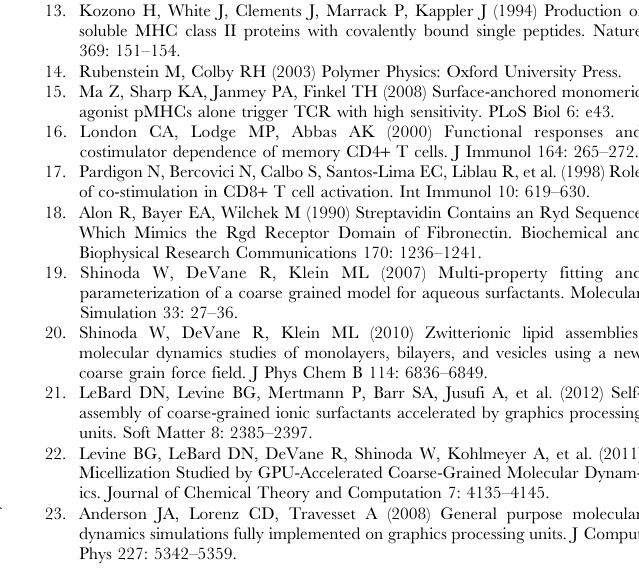
time and 0 second intervals. Figure S3 Similar densities of IEk-MCC tethered on plastic through PEG linkers of different lengths. IEkMCC-PEG conju- gates at the indicated concentrations were incubated overnight at 4 u C on streptavidin-coated 96-well plates. After washing, IEkMCC was detected using the IEk-specific antibody 14-4-4s and goat anti-mouse HRP. Figure S4 T cell activation by IEkMCC-PEG 88 is independent of PEG tether, constimulatory molecules, or free PEG linkers. Streptavidin plates were coated with IEkMCC-PEG 88 or IEkMCC-bio (IEkMCC without a PEG linker but biotinylated at the lysine residue of a c-terminal AviTag sequence) at indicated concentrations. To test the effect of costimulatory molecules, plates coated with IEkMCC-PEG 88 were washed and further coated with B7.1-Fc fusion protein (1 nM; R&D Systems, biotinylated at 2.3 biotins per molecule). T cell IL2 production was measured by intracellular staining and flow cytometry after 6 hrs of stimulation. (B) IEkMCC-bio without PEG linker (7.2 nM) was anchored on streptavidin coated plates by incubating overnight at 4 u C. Polymers (200 pM) were then added for 1 hr at room tempera- ture. The PEG polymers were pre-incubated in PBS overnight at room temperature to hydrolyze the maleimide group. T cells were added to the washed plates and incubated for 6 hrs. Percent of IL2 producing cells was determined using intracellular cytokine staining and flow cytometry. The data points are averages of the values from replicate samples with standard deviations. Figure S5 T cell adhesion to plates with tethered ligands is independent of linker length. T cells were added to plates coated with IEkMCC-PEG88, IEkMCC-PEG 5000, or IEkMCC-PEG